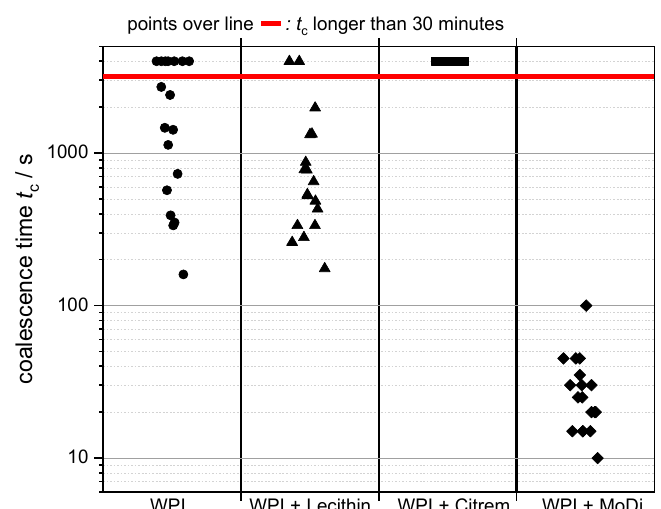
Figure 6. Coalescence time of single droplets with different emulsifier systems. Measurement points above the red line did not coalesce within 30 min. Eighteen droplets were studied for each system.